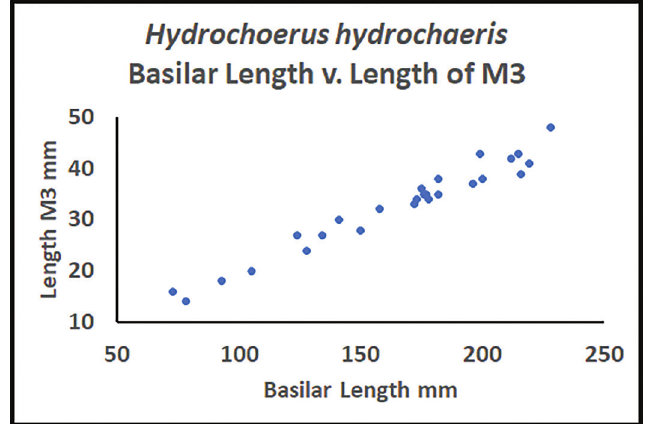
Figure 12. Bivariate plot of the length of M3 plotted against the basilar length of the skull. Data from a sample of extant H. hydrochaeris in Hooijer (1959) and from our sample of extant H. hydrochaeris (Tab. 5).